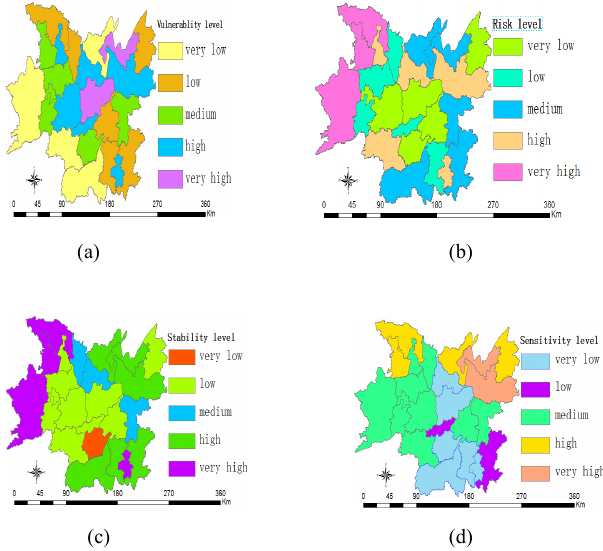
Fig. 9. The flood vulnerability (a) , risk level (b) the stability Fig.9. The flood vulnerability(a),risk level(b) the stability level(c),sensitivity level(d ) in Dongting Lake region level (c) , sensitivity level (d) in Dongting Lake